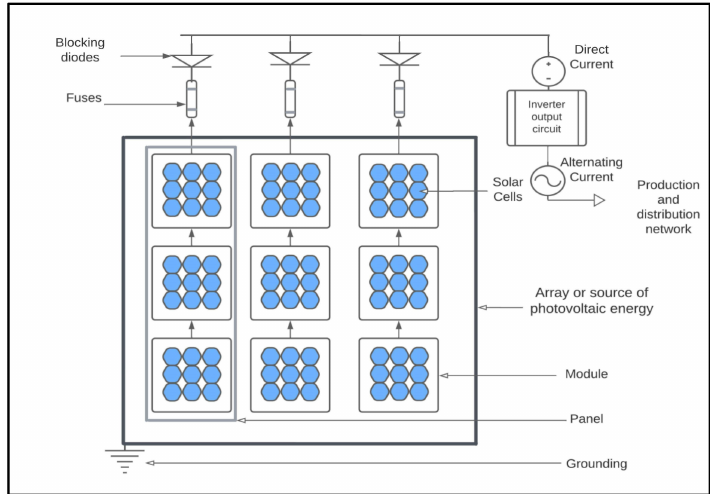
Figure 4. Components of a photovoltaic system based on